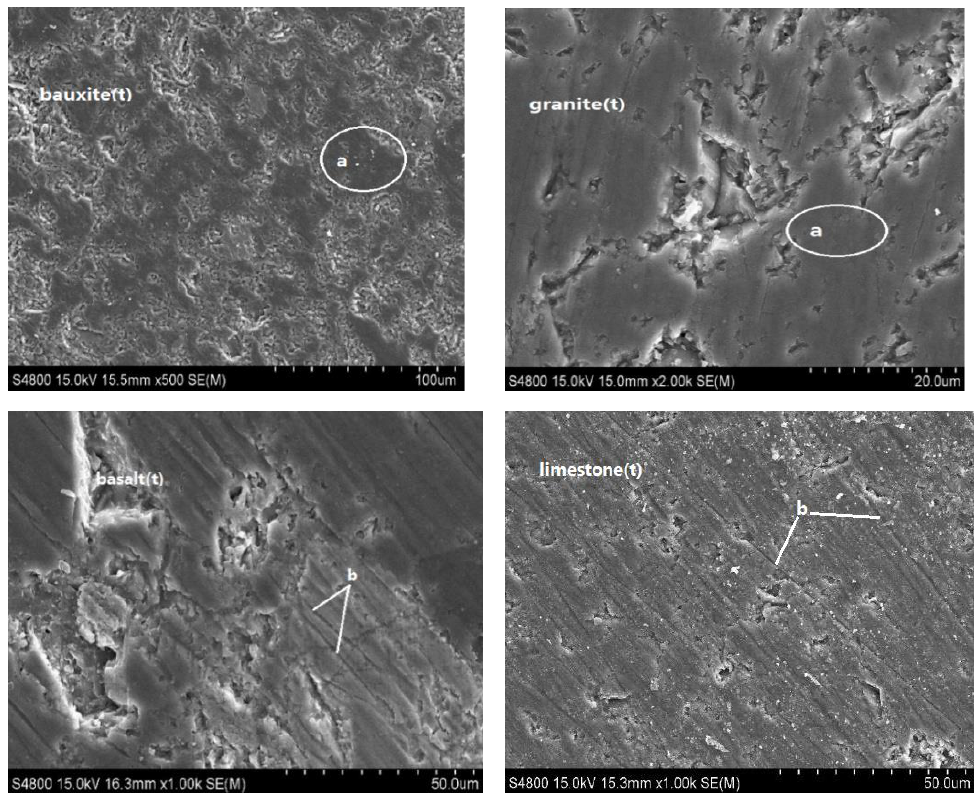
Figure 9. SEM images of the four polished aggregates. a: hard particles that have been polished to a smooth point; b: furrows. smooth point; b: